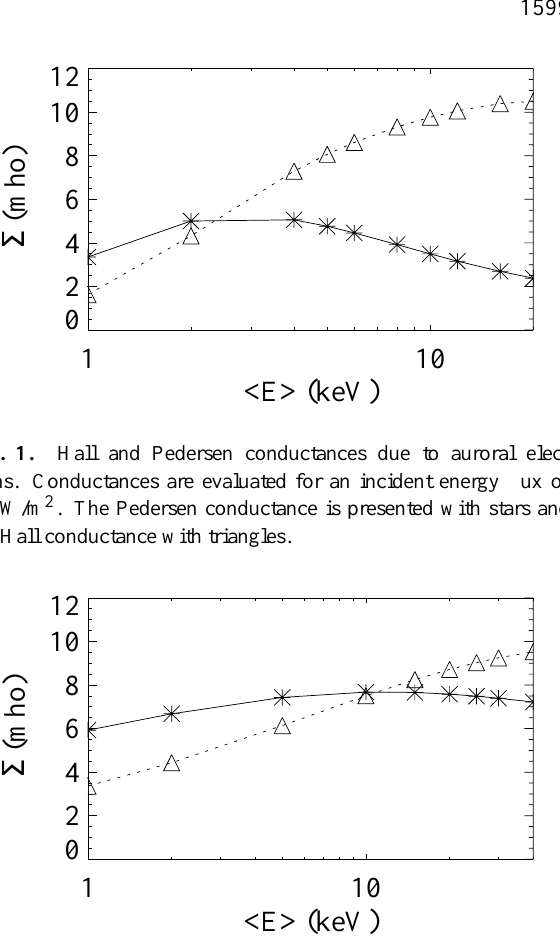
Fig. 2. Hall and Pedersen conductances due to auroral protons. Conductances are evaluated for an energy flux of 1mW/m 2 . The Pedersen conductance is presented with stars and the Hall conduc- tance with